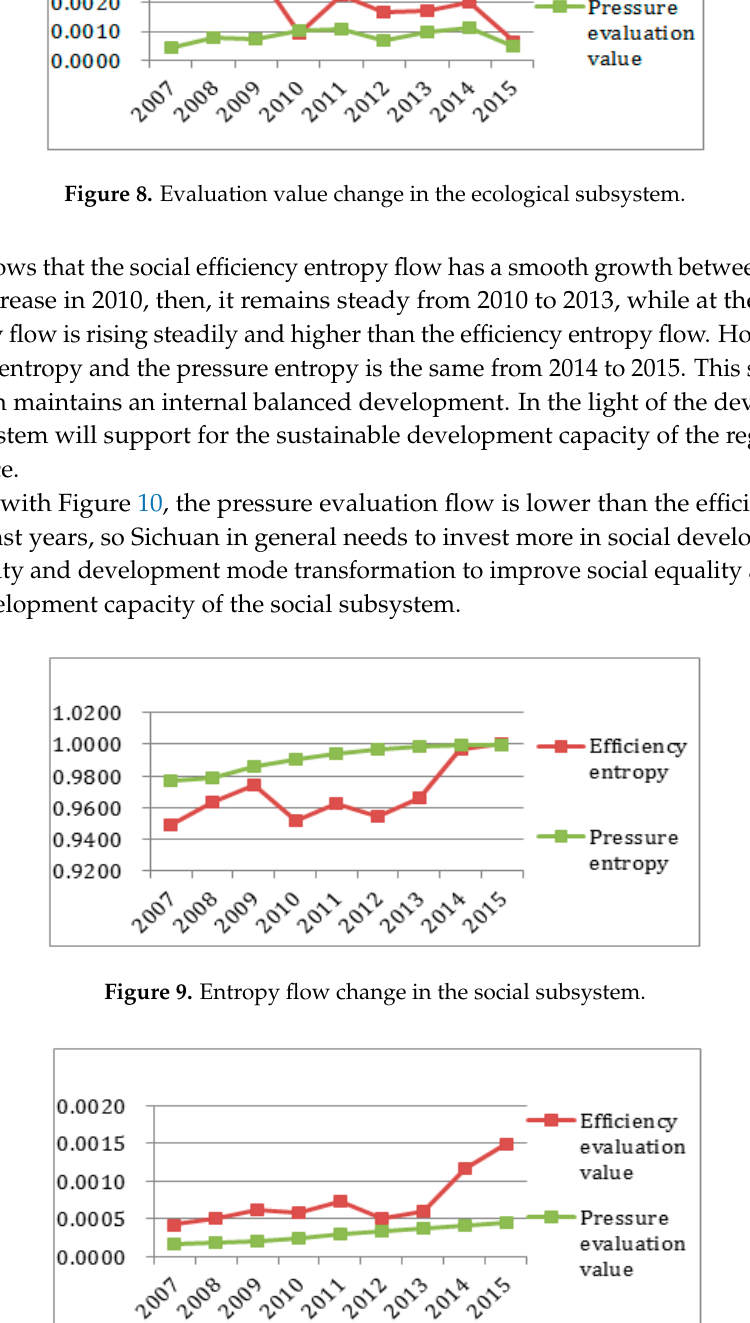
Figure 7. Entropy flow change in the ecological subsystem.